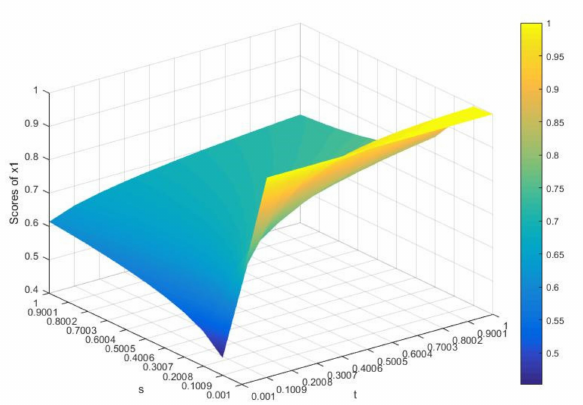
Figure 9. Scores of x 1 obtained by the IFTPGWHM ( t , s ∈ [ 0.001,1 ] ).